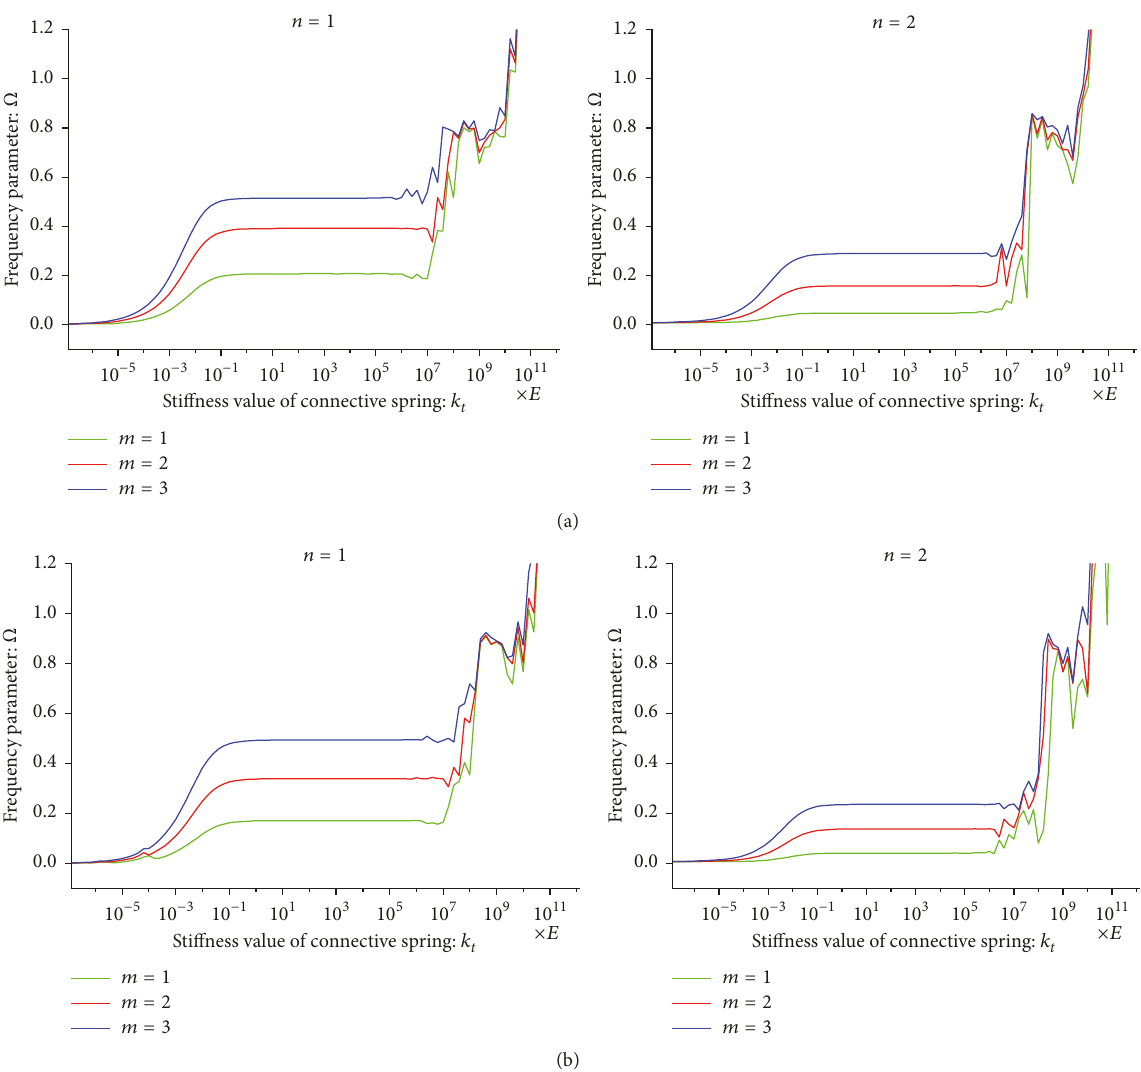
Figure 2: The convergence characteristics of nondimensionless frequency parameters for two vessels: (a) ECE vessel; (b) PCE